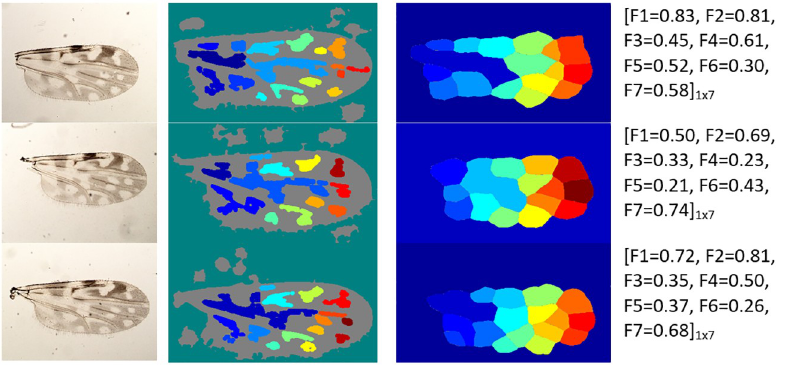
Fig 7. Performance of the proposed method on C. insignis species samples. From left to right column: original wing image, particle detection, segmentation of zones of interest through the watershed method, and the final feature vector output